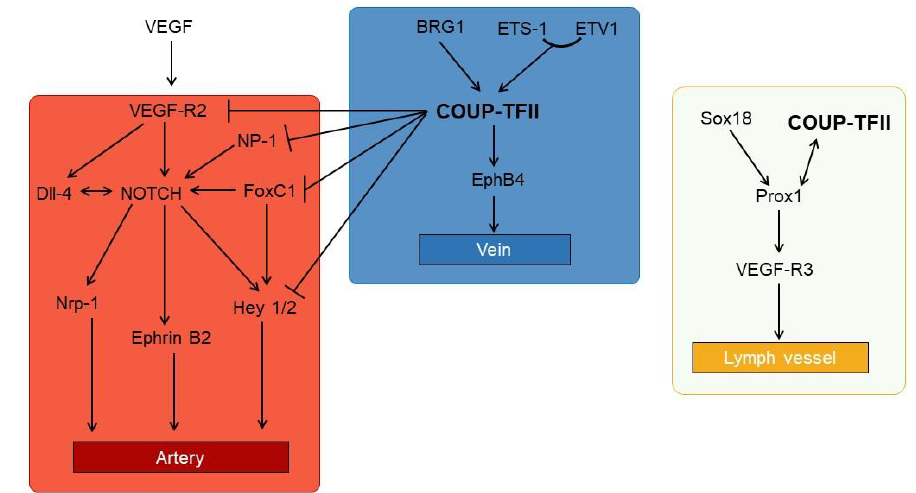
Figure 4. Cell signaling determination of artery, vein and lymph identity. COUP-TFII is one of the main determinants of vein specification. Early in differentiation, COUP-TFII, under the control of BRG-1 and ETS members (ETS-1 and ETV1), induces the expression of vein markers and represses components of the Notch pathway. Later, together with Sox18, COUP-TFII allow the expression of Prox1 and regulates lymphatic vessels differentiation. Based on References [84,85,92–99]. Redrawn from [85], published by Elsevier, 2019.